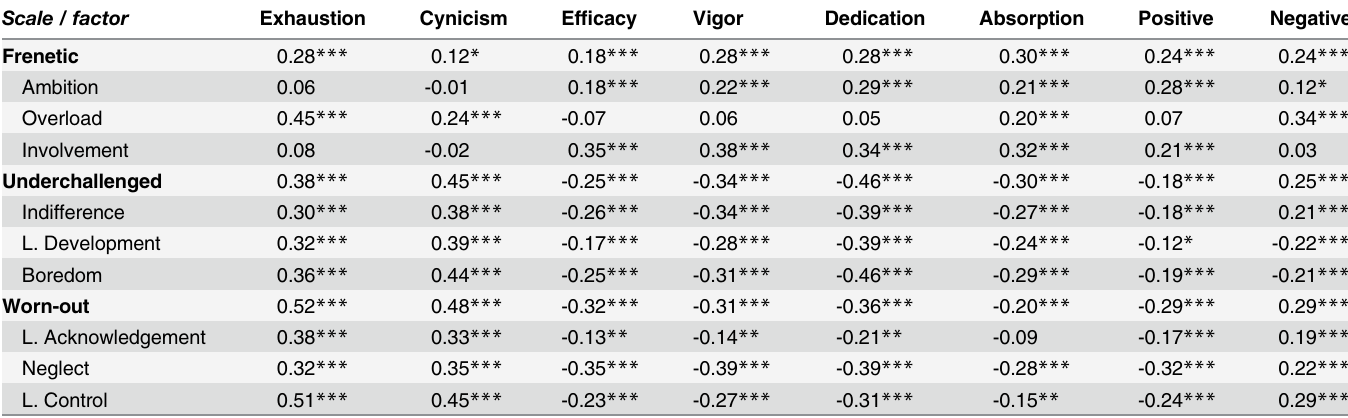
Table 2. Convergent/divergent validity of the